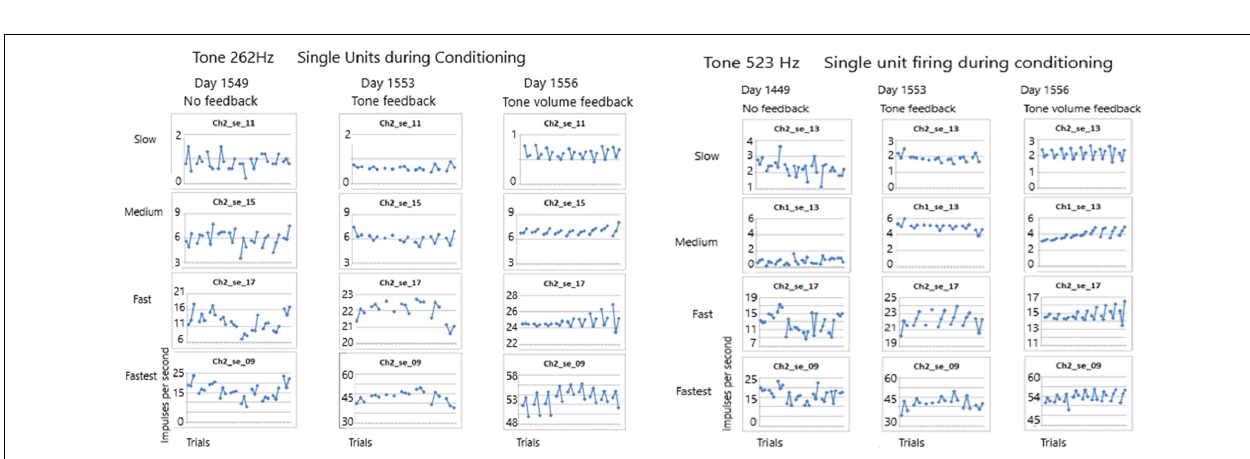
FIGURE 6 | Rate histogram of SU firing over 15 s separate slow (about 1 Hz) to fastest firing SUs (about 100 Hz). The slowest SUs also had the highest amplitude, suggesting they may be Betz cells, whereas the fastest SU had lowest amplitude, suggesting they may be interneurons.